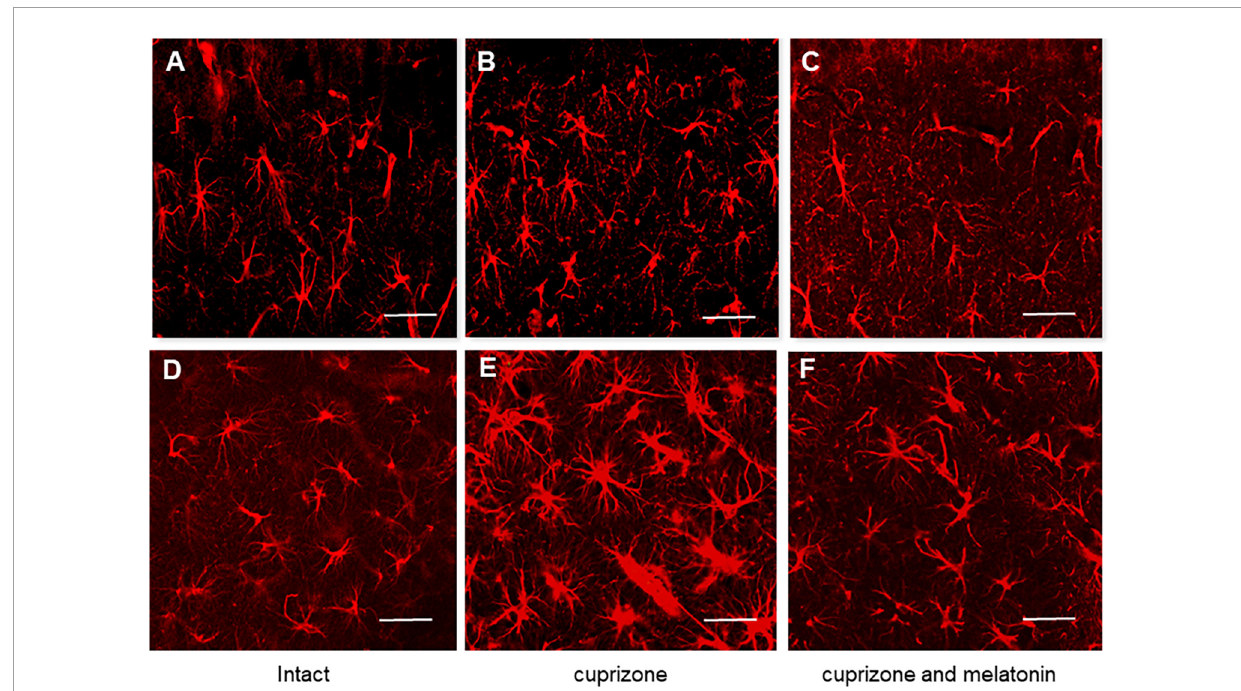
FIGURE4 Confocal images of immunohistochemical staining of hippocampal CA1 area in intact (A,D) , cuprizone treated (B,E) and (C,F) cuprizone + melatonin treated mice. Immunohistochemical staining using the astrocyte marker GFAP in the hippocampal slices ( n = 10) of mice ( n = 5 in each group). (A–C) Young mice, (D–F) aging mice. Note a prominent outgrowth of GFAP-positive cells in panels (B,E) after cuprizone treatment (3 weeks). Scale bar, 50 µ m.